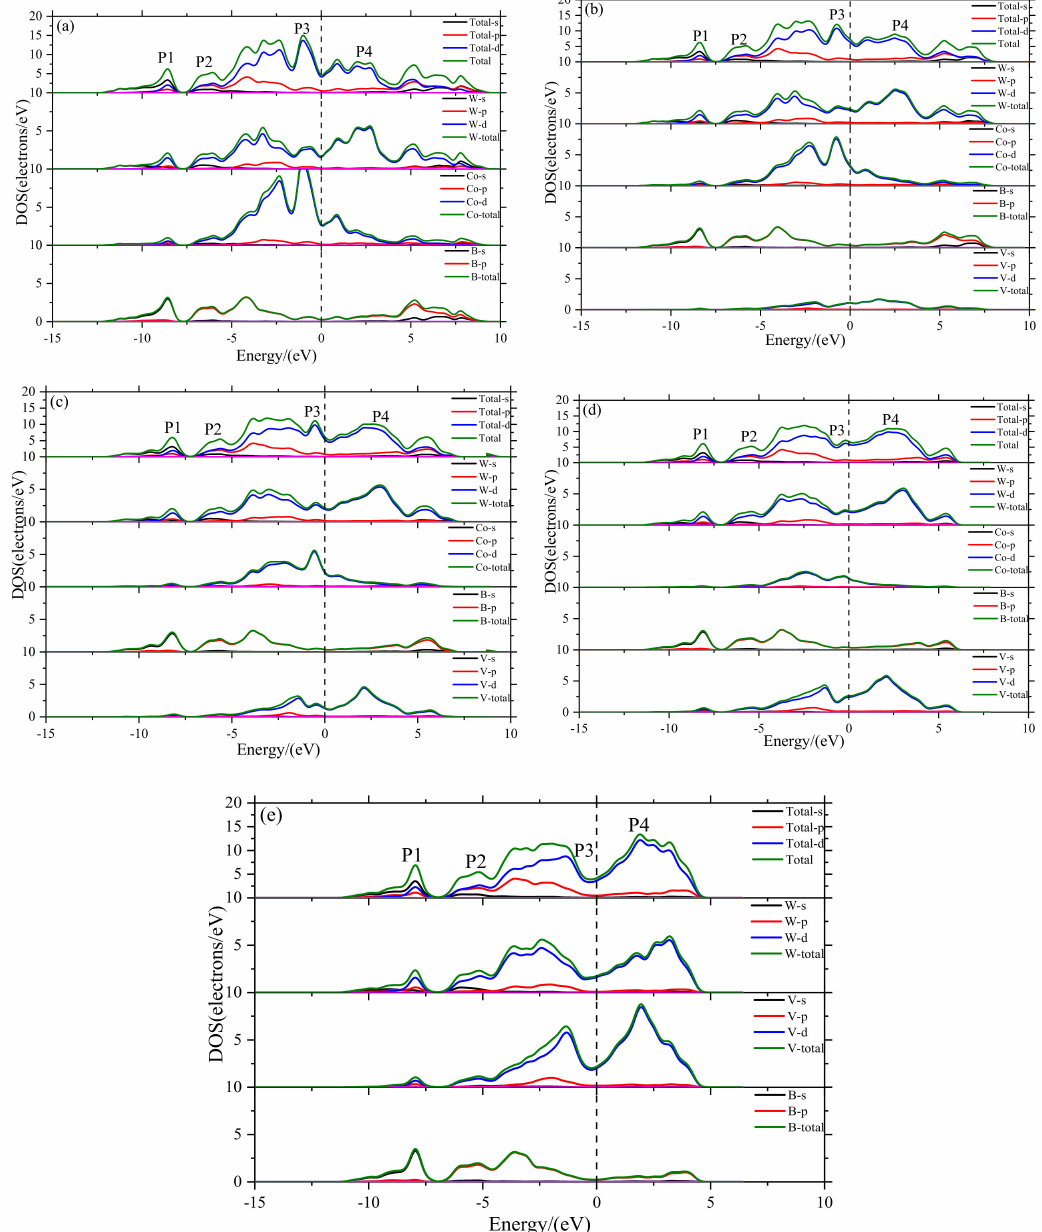
Figure 4. Plots of total and partial density of states of WCoB with different Mn doping content (( a ) W 4 Co 4 B 4 ; ( b ) W 4 Co 3 VB 4 ; ( c ) W 4 Co 2 V 2 B 4 ; ( d ) W 4 CoV 3 B 4 ; ( e ) W 4 V 4 B 4